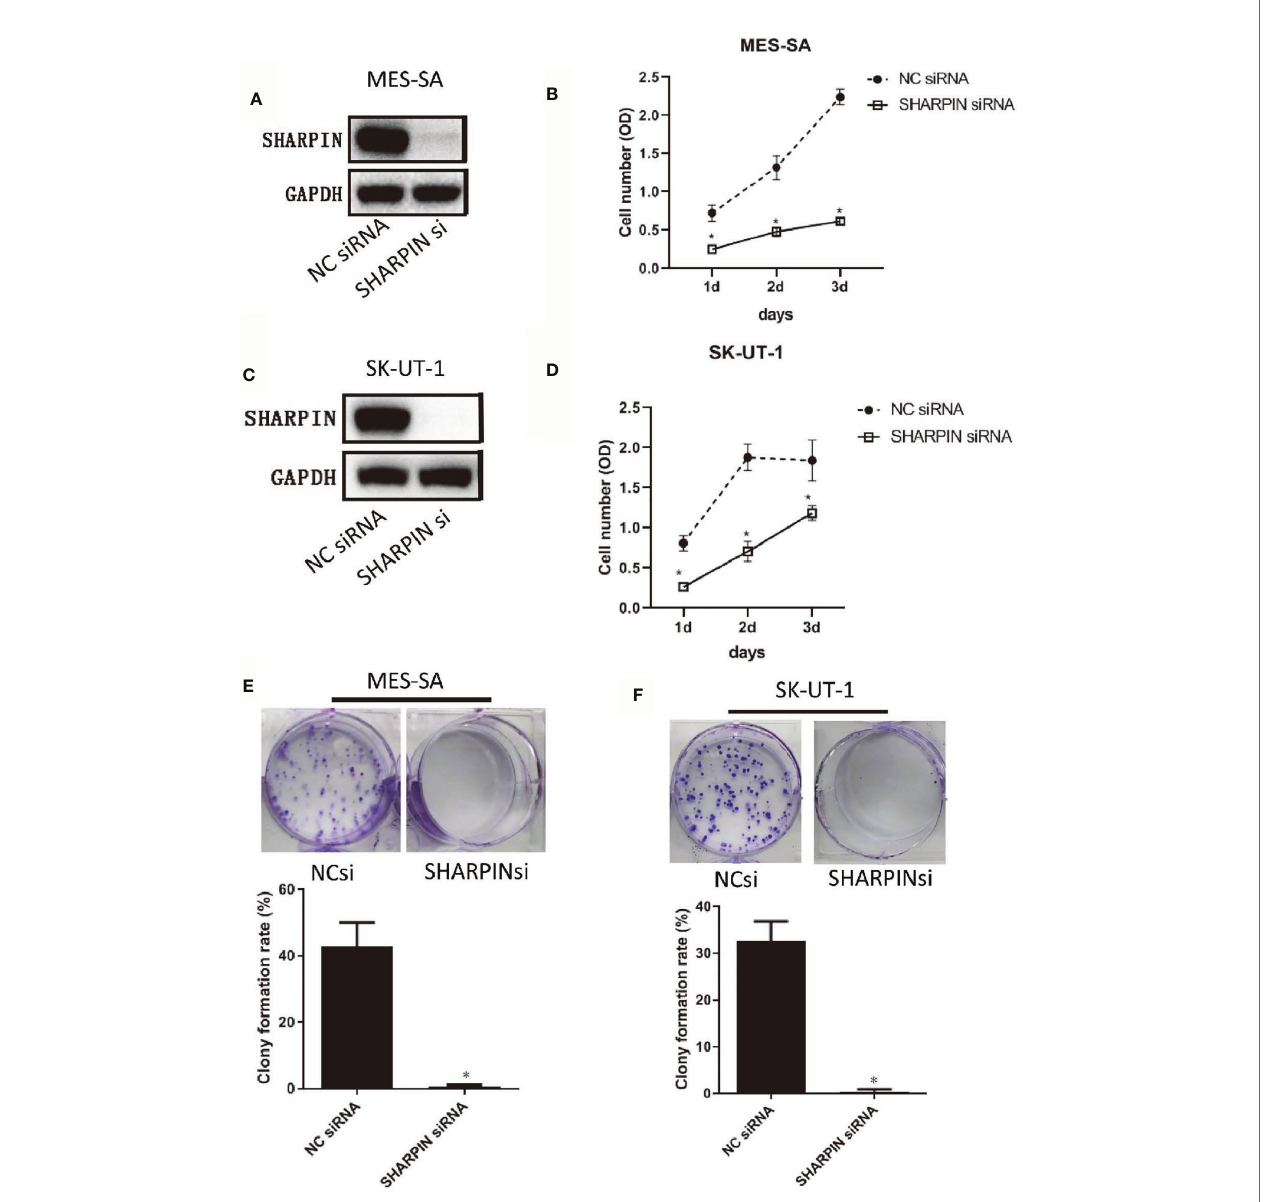
FIGURE 3 | Knockdown of SHARPIN expression decreased uterine sarcoma cell proliferation and colony formation. (A) , Western blot analysis of SHARPIN expression in MES-SA cells transfected with negative control (NC) siNRA or SHARPIN siRNA for 72 h. (B) , MES-SA cells were transfected with SHARPIN or NC siRNA for 72 h and plated in 96-well plates. Cell proliferation was analyzed daily by the CCK-8 assay during the following three days. Data were obtained from three independent experiments in triplicate. (C) , Western blot analysis of SHARPIN expression in SK-UT-1 cells transfected with NC siNRA or SHARPIN siRNA for 72 h. (D) , SK-UT-1 cells were transfected with SHARPIN or NC siRNA for 72 h and plated in 96-well plates. Cell proliferation was analyzed daily by the CCK-8 assay during the following three days. Data were obtained from three independent experiments performed in triplicate. *p < 0.05 vs. NC shRNA; n = 3. (E, F) , Colony formation assay of MES-SA (E) and SK-UT-1 (F) cells after transfection with SHARPIN or NC siRNA for 72 h. *p < 0.05 vs. NC shRNA; n = 3. Full-length blots from Figures 3A, C are shown in Figure S5